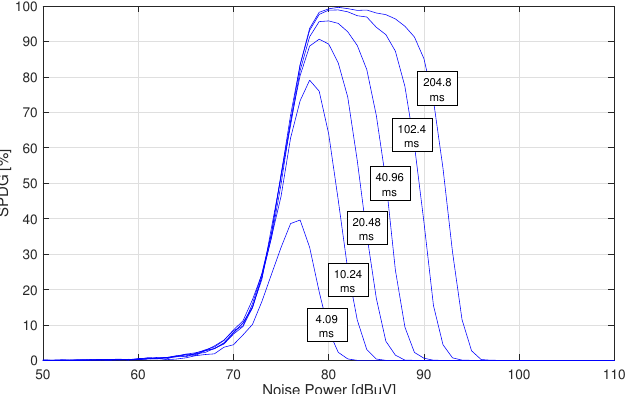
Figure 14. Successful path detection gain (SPDG) vs. transmission delay, with respect to the PT